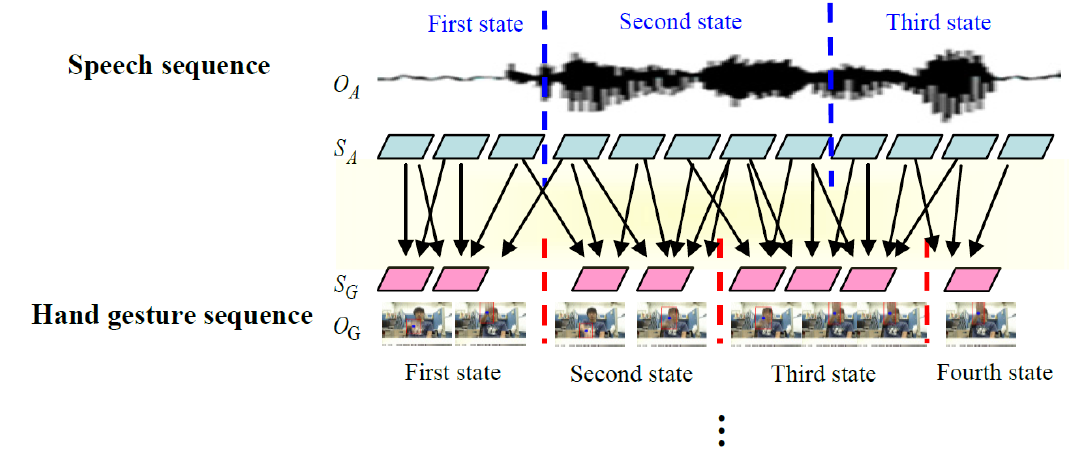
Figure 20. Correspondence between state sequences of optimal speech and hand